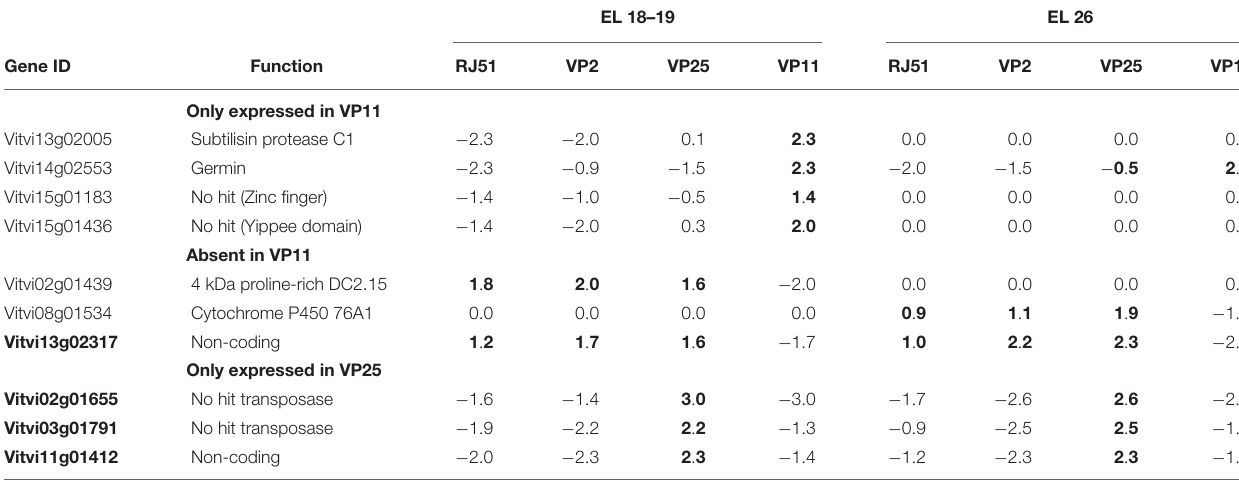
TABLE 4 | List of genes only expressed or never expressed in one loose clone at least in one stage (EL 18–19 or E-L 26) in RNAseq analysis.